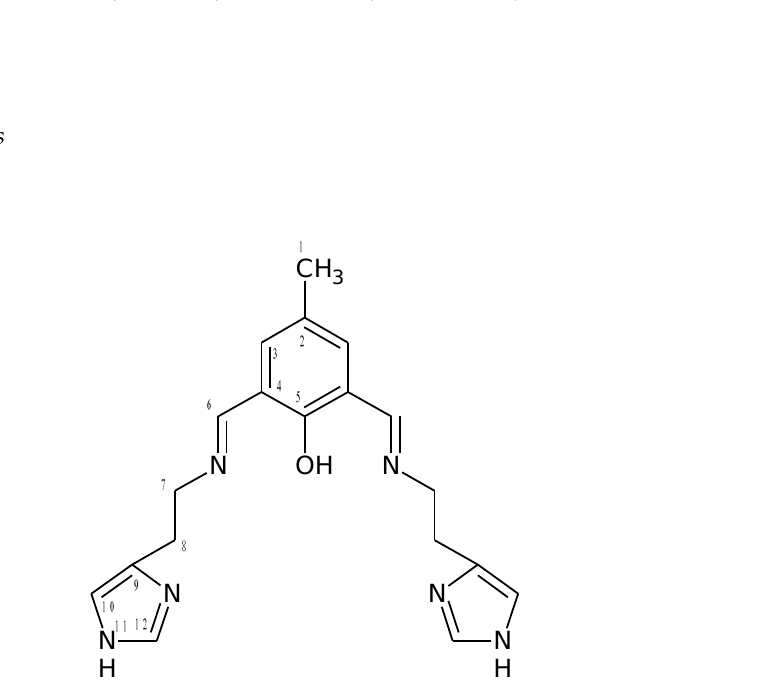
Figure 15. Structural formula and atomic numbering scheme for HL1 .